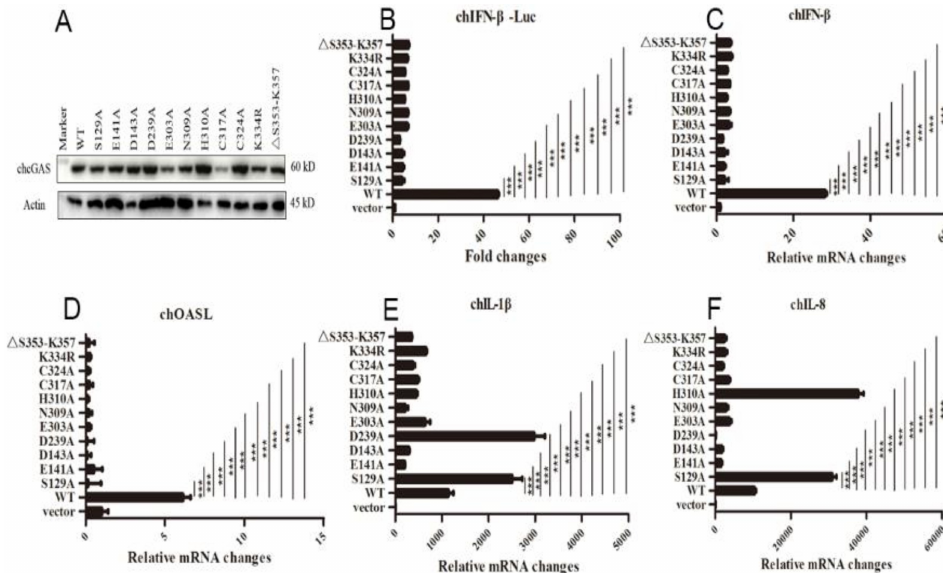
Figure 4. The expressions and activities of chGAS mutant proteins. ( A ) 293T in 24-well plates (2 × 10 5 cells / well) were transfected with chGAS mutants (0.5 µ g each), and 24 h later the cell lysates were analyzed by Western-blotting with anti-FLAG mAb. ( B ) Di ff erent chcGAS mutants (20 ng each) were co-transfected with chSTING (10 ng) plus chIFN β Fluc reporters into HD11 cells in 96-well plate (3 × 10 4 cells / well), and 24 h later, the cells were subjected to luciferase measurement. ( C – F ) HD11 cells in 12-well plate were co-transfected with chcGAS mutants (0.8 µ g) and chSTING (0.4 µ g), and 24 h later the cells were analyzed by RT-qPCR for cellular IFN β , OASL, IL-1 β and IL-8 gene transcriptions. The signs “***” denote p <